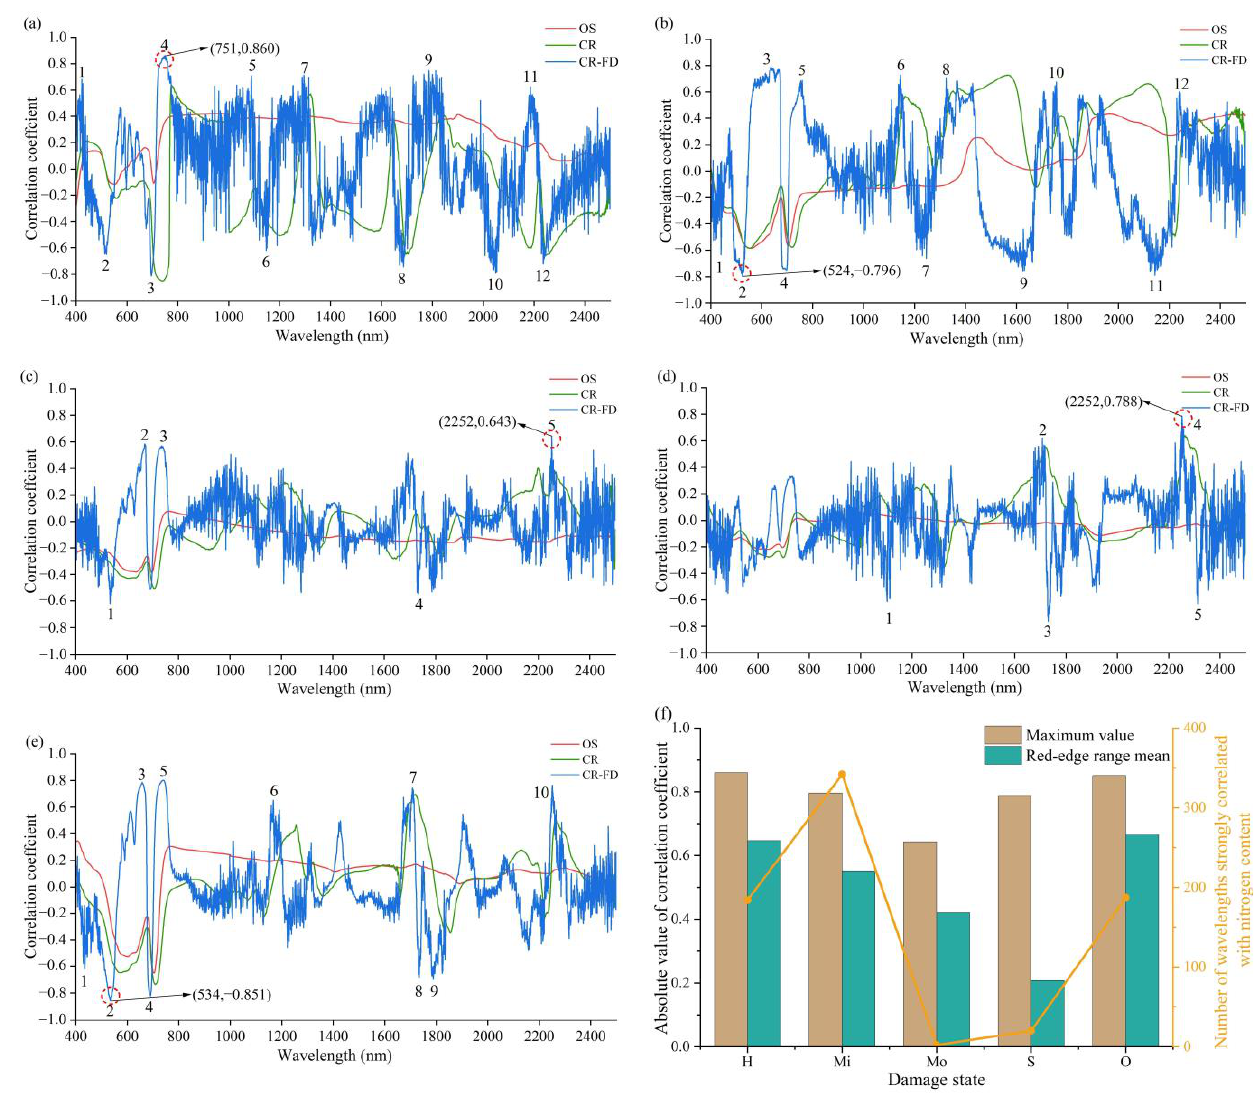
Figure 7. Correlation analysis of spectral data and nitrogen content of Moso bamboo leaves in different states: ( a – e ) correlations between spectral data and nitrogen contents of leaves in H, Mi, Mo, S, and O states, respectively. ( f ) Correlations between nitrogen content and spectral characteristics. Table 1. Construction of relationship models for Moso bamboo leaves in different damage